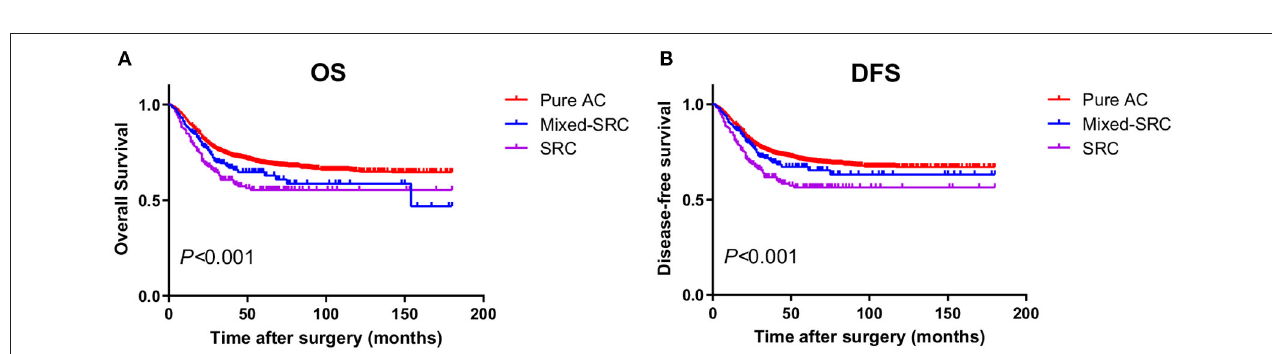
were more associated with female, younger age, higher pN stage, and more lymphovascular invasion (all p <